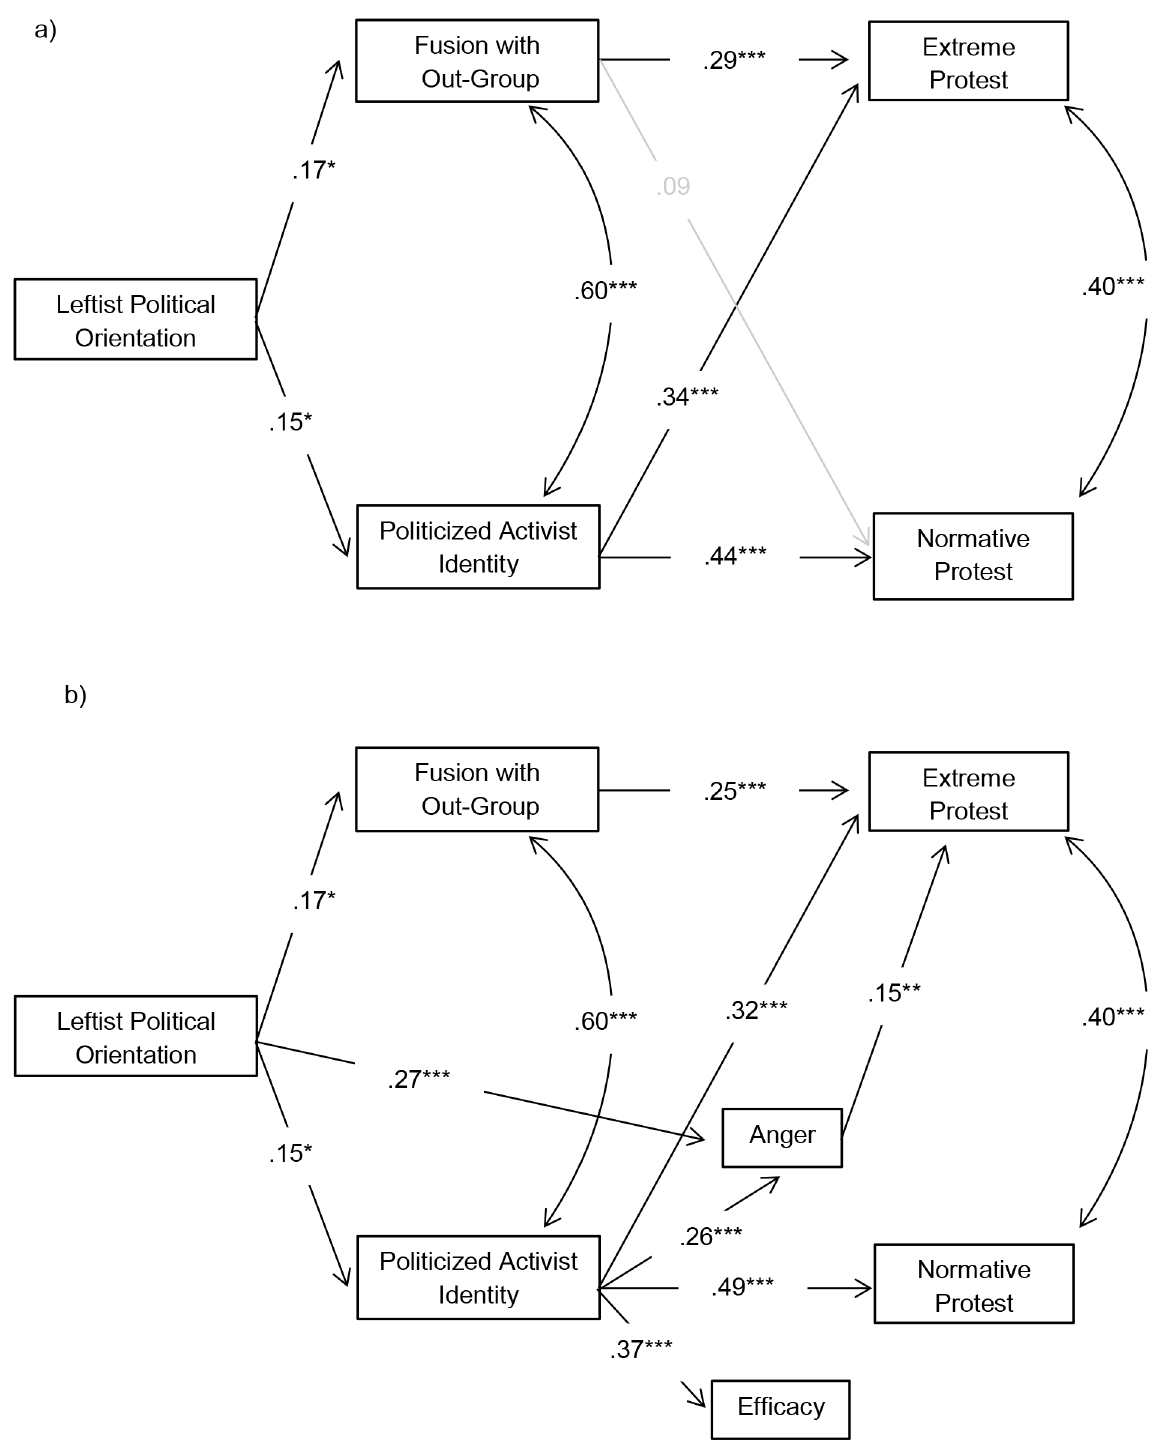
Fig 1. Simple (a), and more complex and fitted (b), mediationmodels for Study 1 are displayed. Non-significant paths are displayed in grey. The correlationbetweenanger and efficacy in Model b) is not displayedfor purposesof presentation: r anger, efficacy = .30, p <